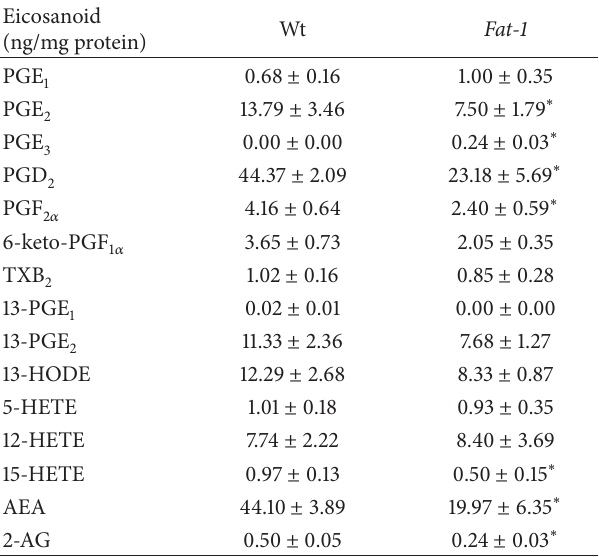
Table1:ColonicmucosaleicosanoidandcannabinoidprofilesinWt and Fat-1 TNBS-treated mice 1